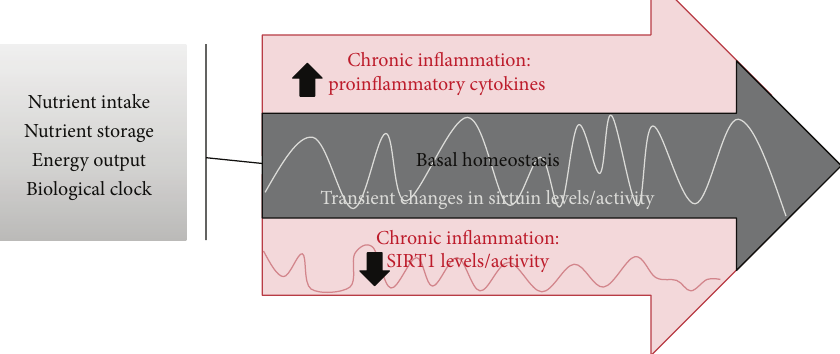
Figure 1: Sirtuins and chronic inflammation: during homeostasis (grey arrow), there are small perturbations in sirtuin levels without inflammation. During chronic inflammatory states (denoted by pink), persistent decreases in SIRT1 levels/activity sustain glycolysis- dependent proinflammatory pathways. This immunometabolic inflexibility alters the bioenergy homeostasis set point, which is rebalanced by increasing SIRT1